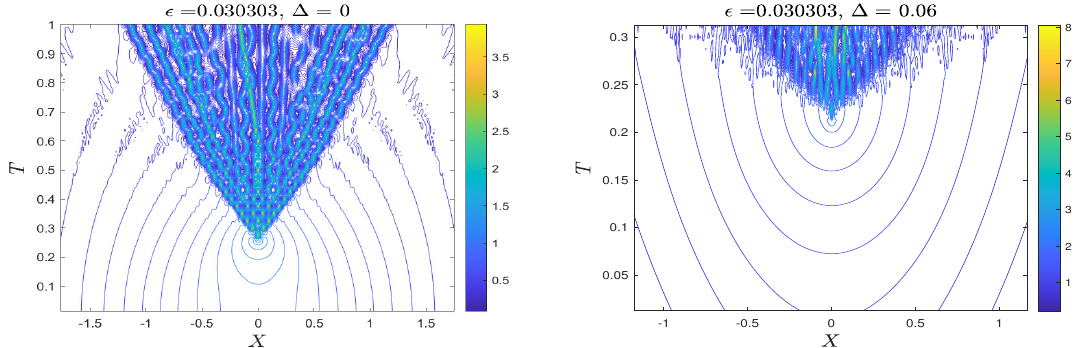
Figure 9. Case 3: The initial condition is (13) with γ = 1.0, (cid:101) = 1/33, M = 1 and ∆ = 0, ∆ =